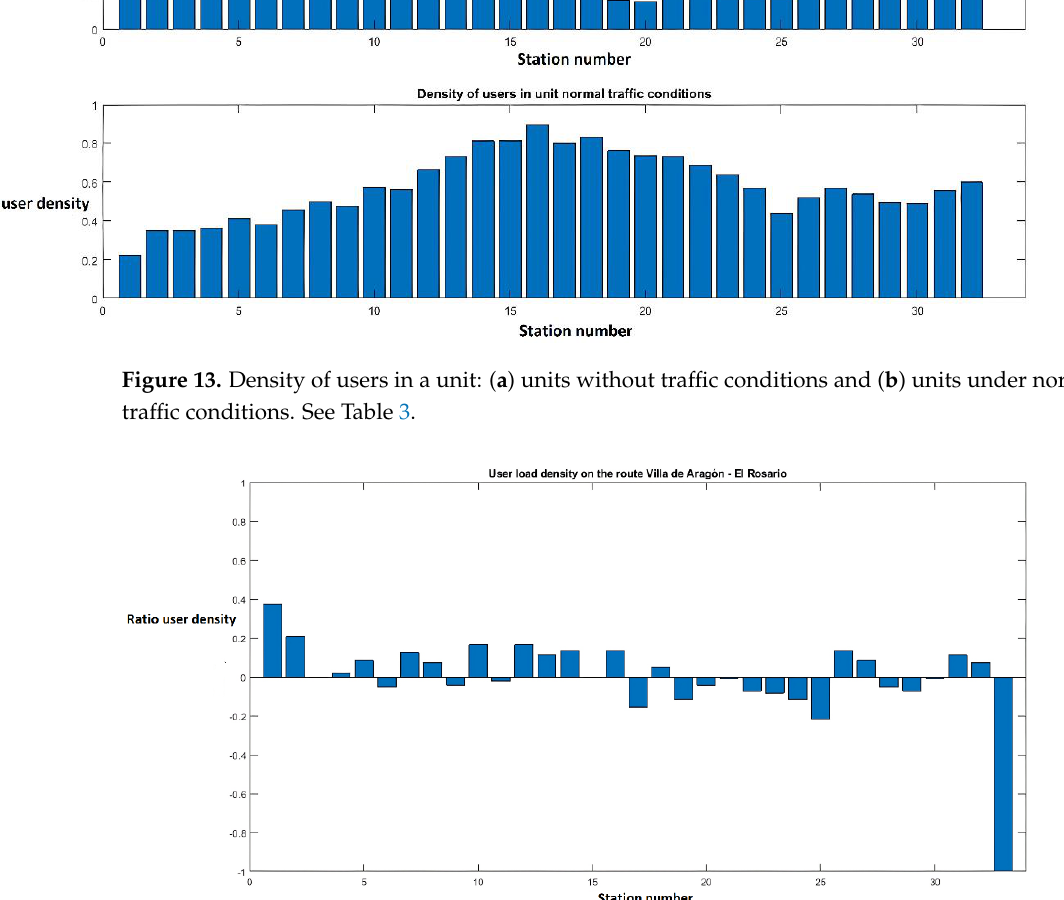
Figure 14. Load density of users on the Villa de Aragón-El Rosario route.